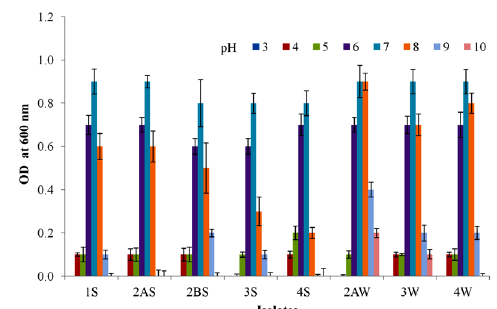
Fig. 3. Growth profile of isolates at pH range 3-10 for 24 h in nutrient broth